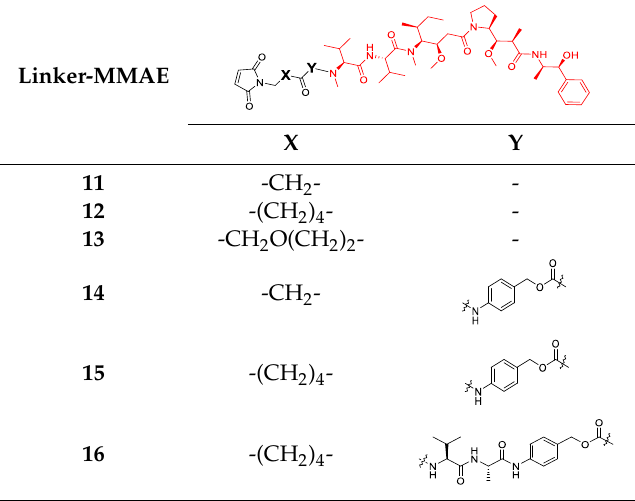
Table 1. Structures of the synthetic linker-MMAE conjugates.